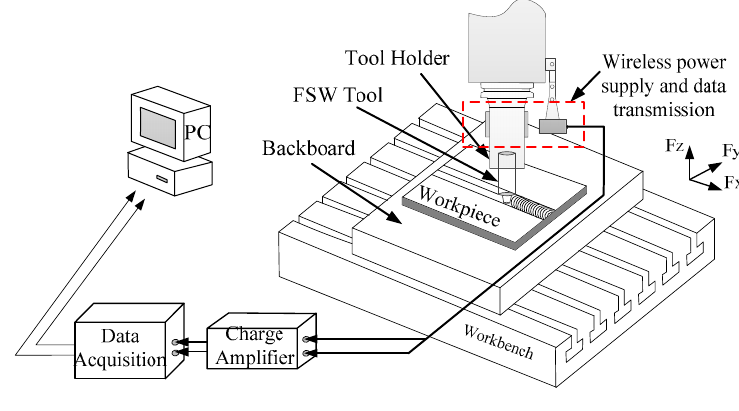
Figure 5. Signal acquisition method.